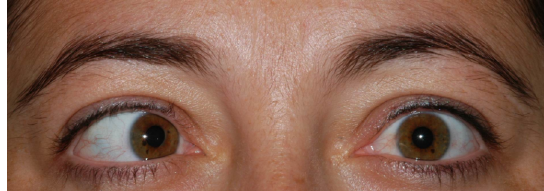
Figure 1: The patient had right esotropia in primary position.